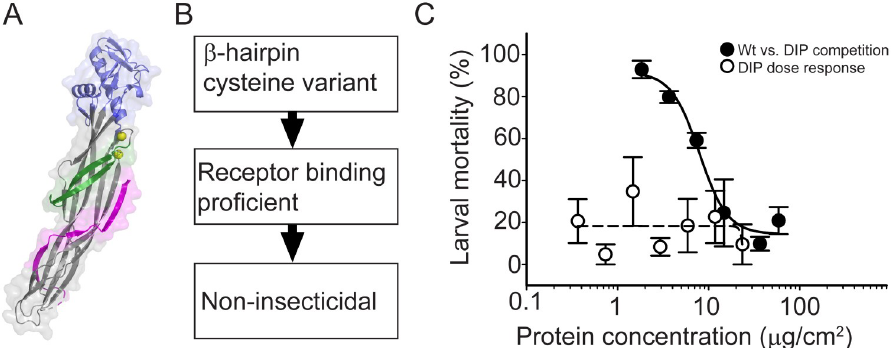
Fig 4. Competition bioassay with wild-type and disabled insecticidal protein (DIP) variant Mpp75Aa1.1_K125C_N153C. (A) Cartoon representation (PyMOL ™ 2.0.2) of DIP variant. Double-cysteine substitutions K125C_N153C are represented by yellow spheres. (B) Description of DIP variant functional properties. (C) Mass action in vivo competition. Wild-type Mpp75Aa1.1 (7.35 μ g/cm 2 ) was mixed with increasing concentrations (from 1.83 to 58.8 μ g/cm 2 ) of the DIP-variant to measure WCR larval mortality. DIP-variant loss of insecticidal activity, likely caused by disabled pore formation, did not affect binding, as shown by effective competition. Data points represent mean mortality ( ±